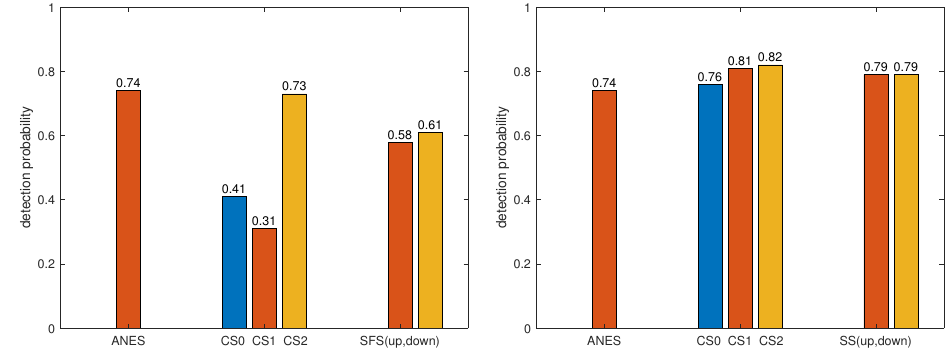
( b ) The radar with ANES and the jammer with ele- mentary strategies